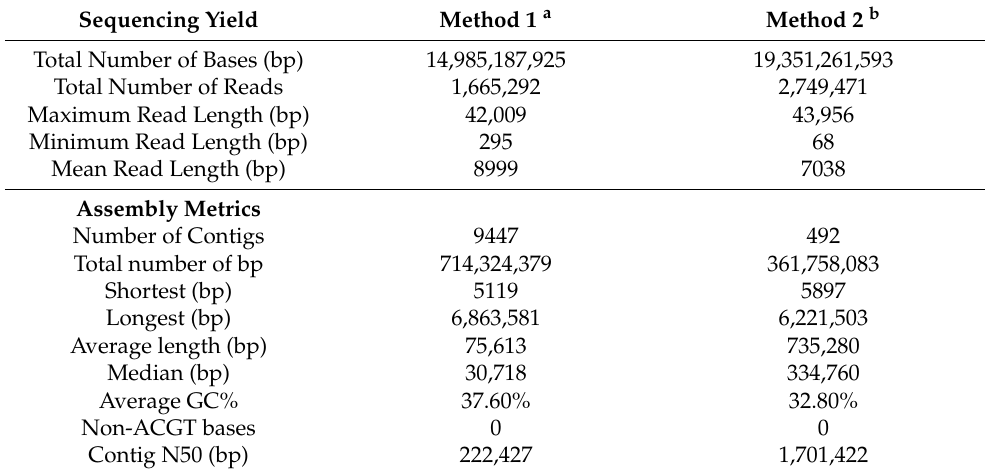
Table 1. Sequencing yield and assembly metrics for Pratylenchus scribneri raw hifiasm libraries constructed using two different DNA isolation